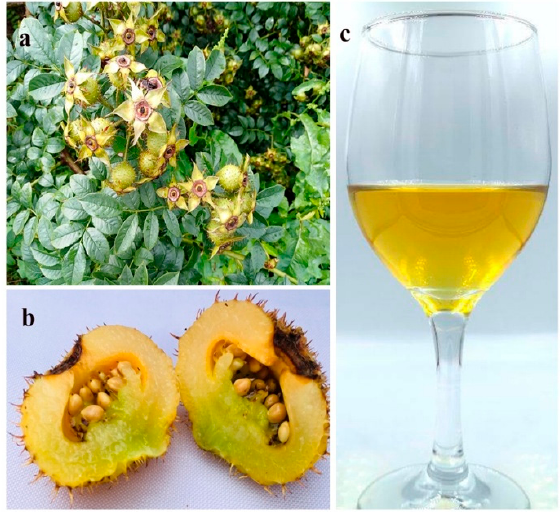
Figure 1. Cili, Rosa roxburghii , cv. Guinong 5 ( a ) growth habit ( b ) mature fruit and ( c ) wine.